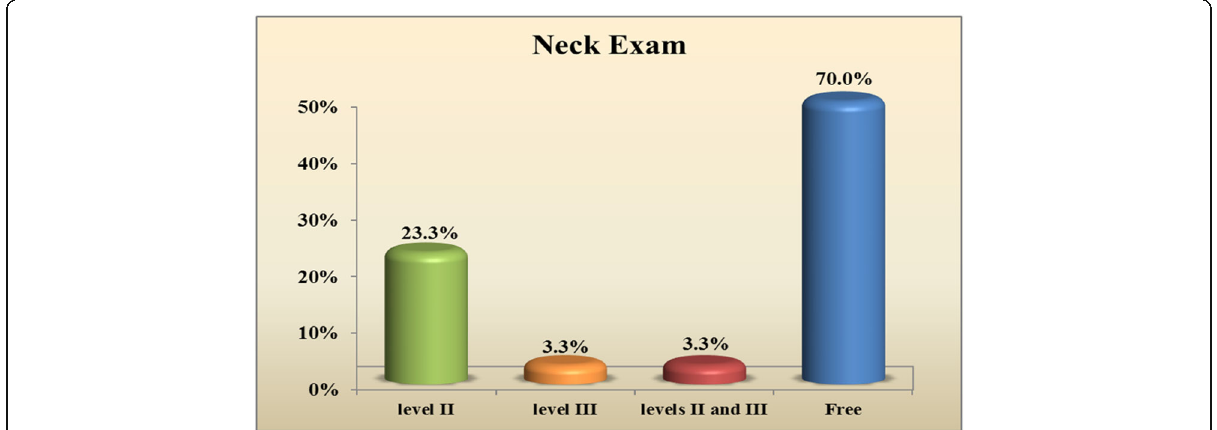
Fig. 1 Lymphatic spread of the primary tumor clinically and